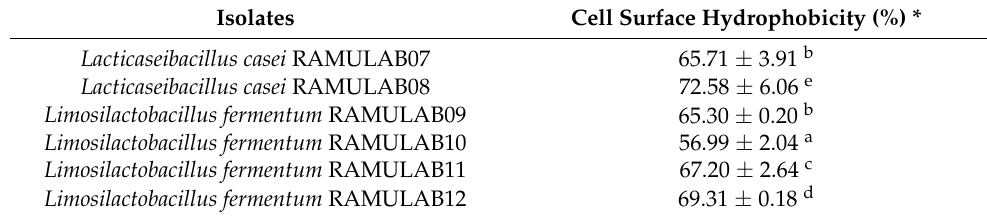
Table 3. The cell surface hydrophobicity of the isolates.